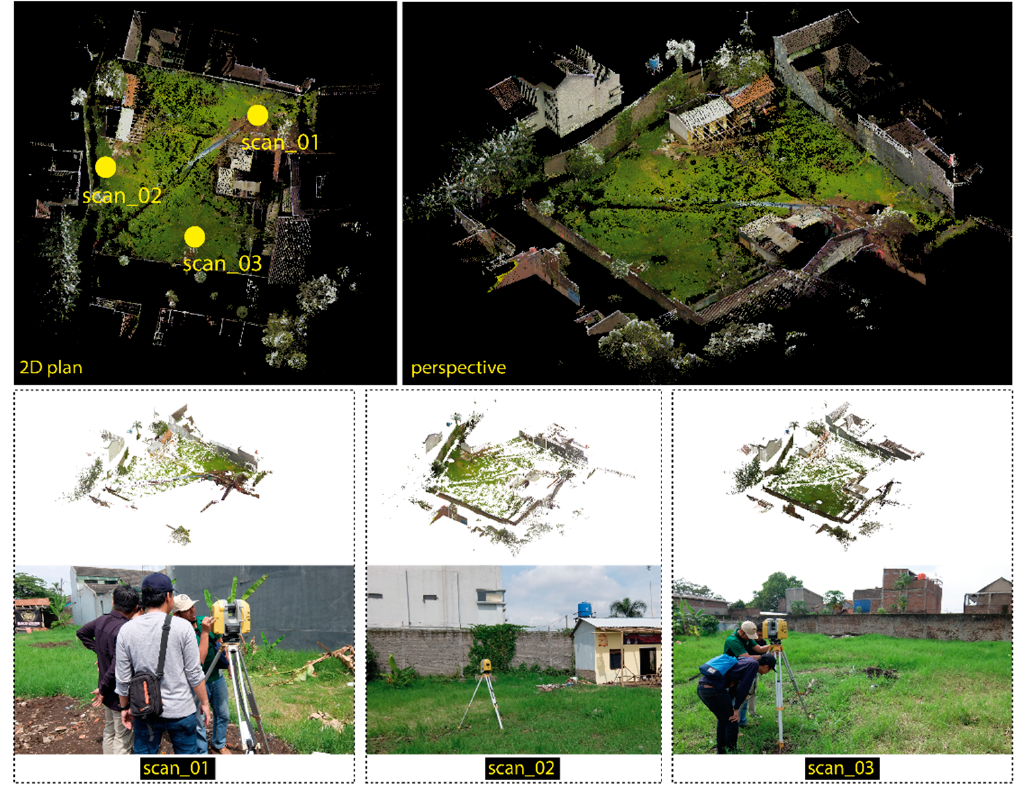
Figure 7. Dataset collection with different views captured in relation to the scanner position.